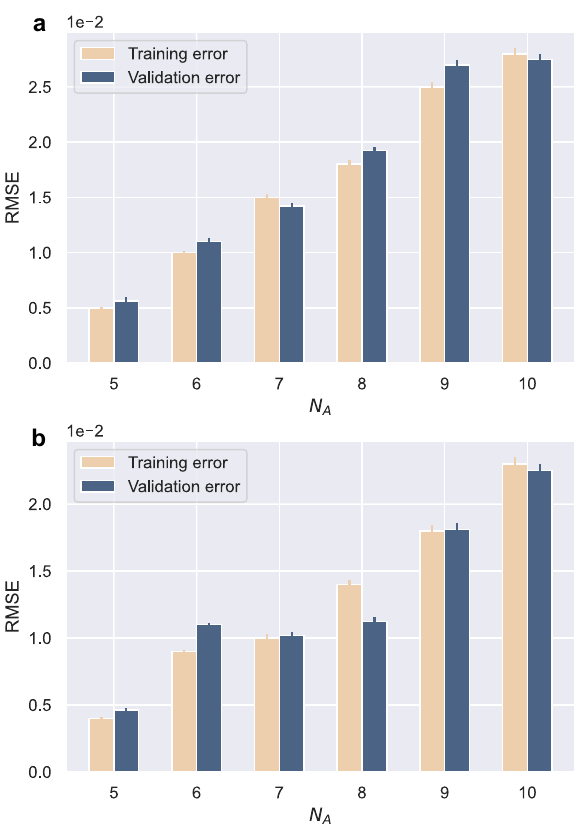
Fig. 4 The numerical performance of the MLCP model in estimating the maximum fi delity of varied subsystem sizes. a The model is trained based on the samples in C 1 . b The model is trained based on the samples in C 2 . In ( a , b ), the measurement setting are set to be N U = 512, N M = 150. The error bar denotes the standard variance of repeated runs with different randomization.